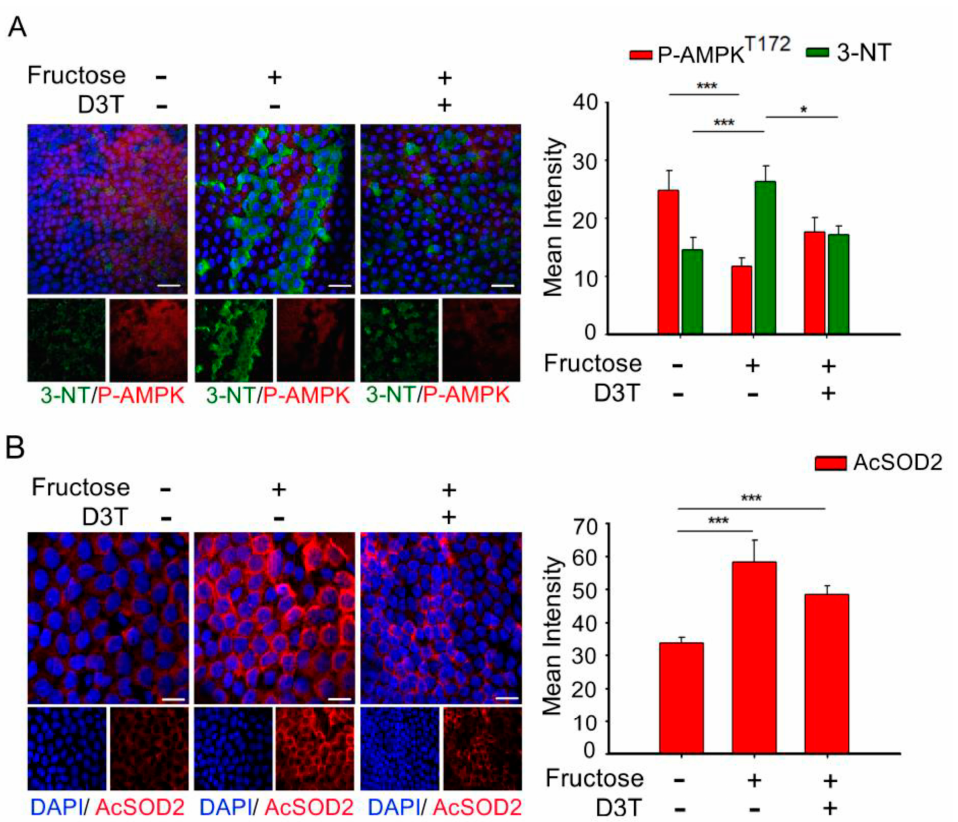
Figure 3. D3T reverses the effects of fructose − upregulated 3 − NT and acetyl SOD2 in the lens of rats with fructose-induced type 2 DM. ( A ) Representative images showing the expression of p-AMPK T172 (red fluorescence) and 3-nitrotyrosine (3-NT, green fluorescence) in the lens with or without systemic administration of fructose or D3T. ( B ) Immunofluorescence assay was also performed for acetyl SOD2 (AcSOD2) (red) in the lens with or without systemic administration of fructose or D3T. All data represented mean ± SEM ( n = 10 per group, independent experiments in each figure). * p < 0.05 and *** p < 0.001.